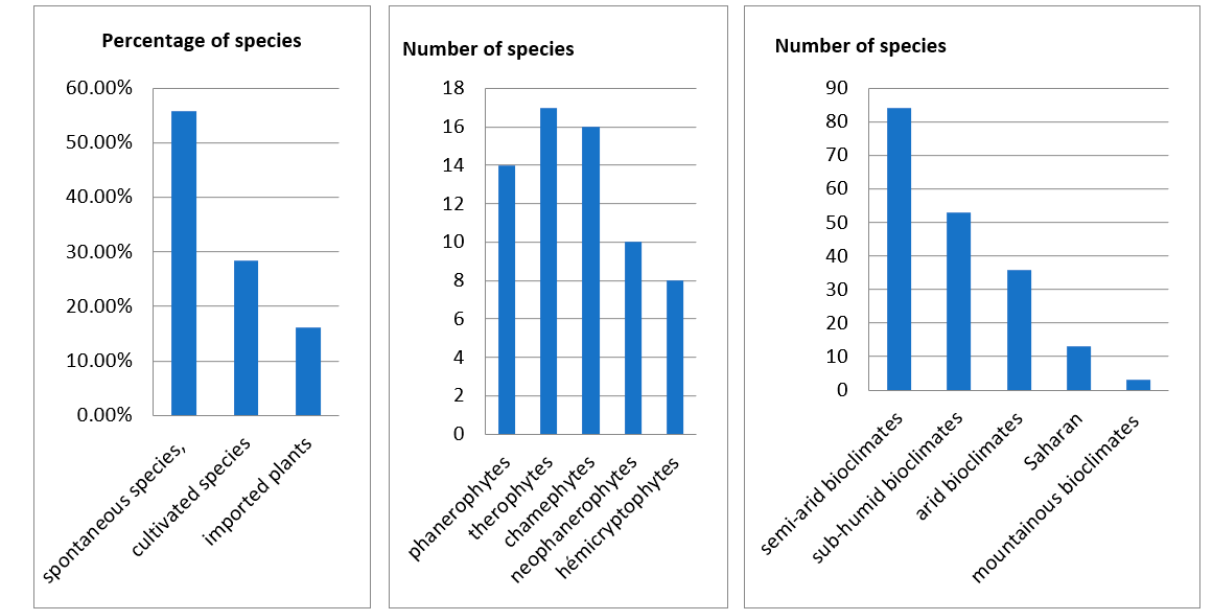
Figure 2. Description of the species.